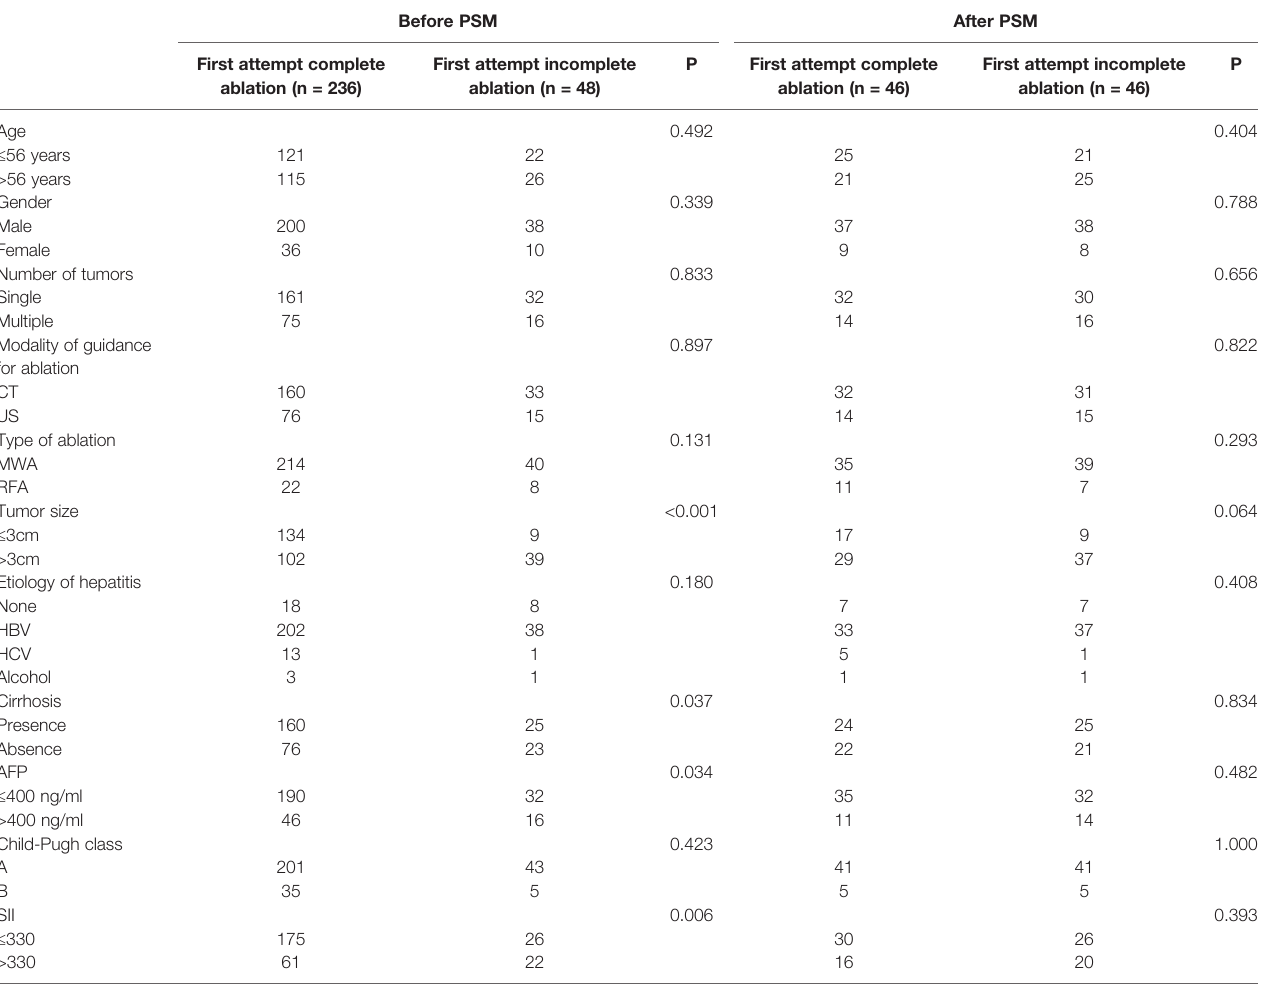
TABLE 2 | Patients ’ baseline characteristics before and after PSM. Before PSM After PSM First attempt complete ablation (n =